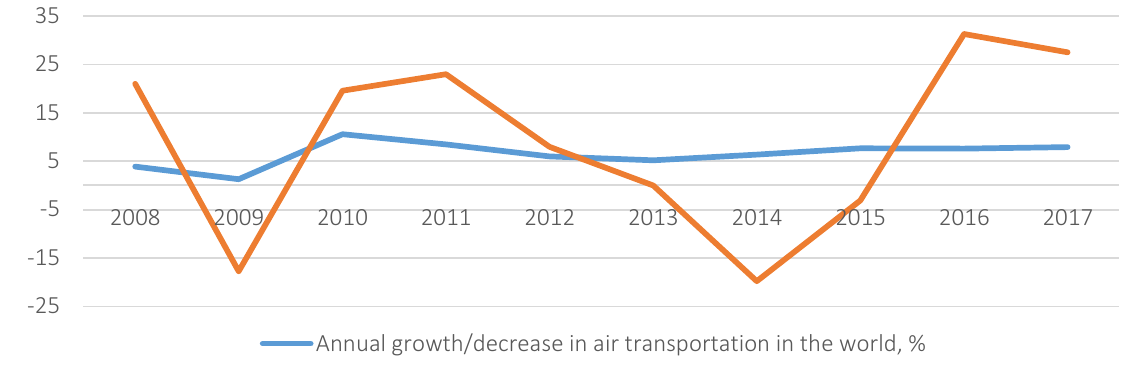
Figure 1. Analysis of the dynamics of air transportation in Ukraine and in the world, %